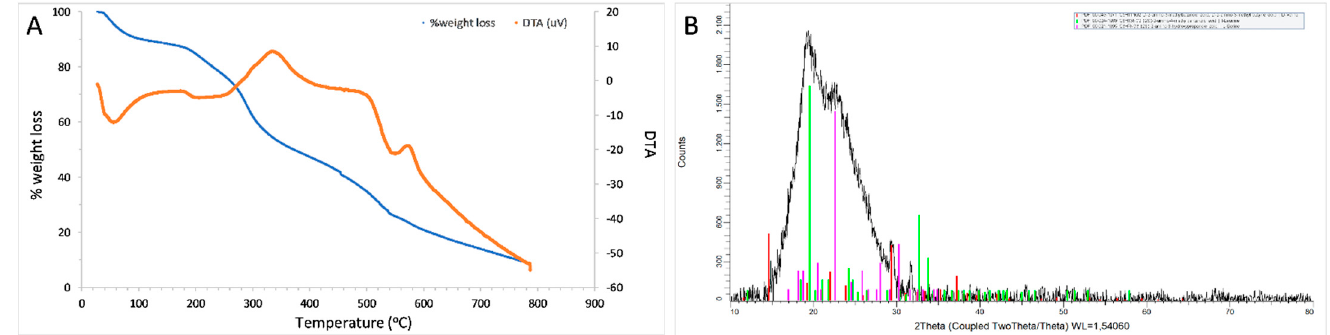
Figure 5. ( A ) Thermal gravimetric analysis (TGA) and differential thermal analysis (DTA) curves, and ( B ) XRD analysis of the novel BS extracted and partially purified by P. citronellolis isolate 620C culture with 1% DCF as substrate.